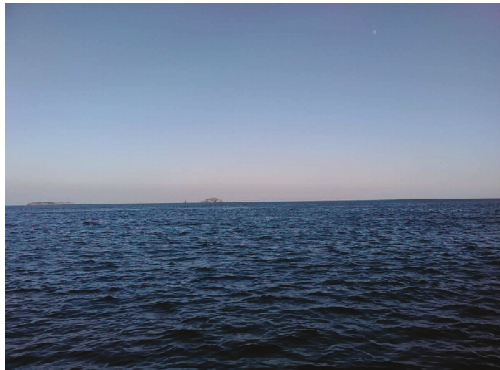
Figure 4. The sea state of the field